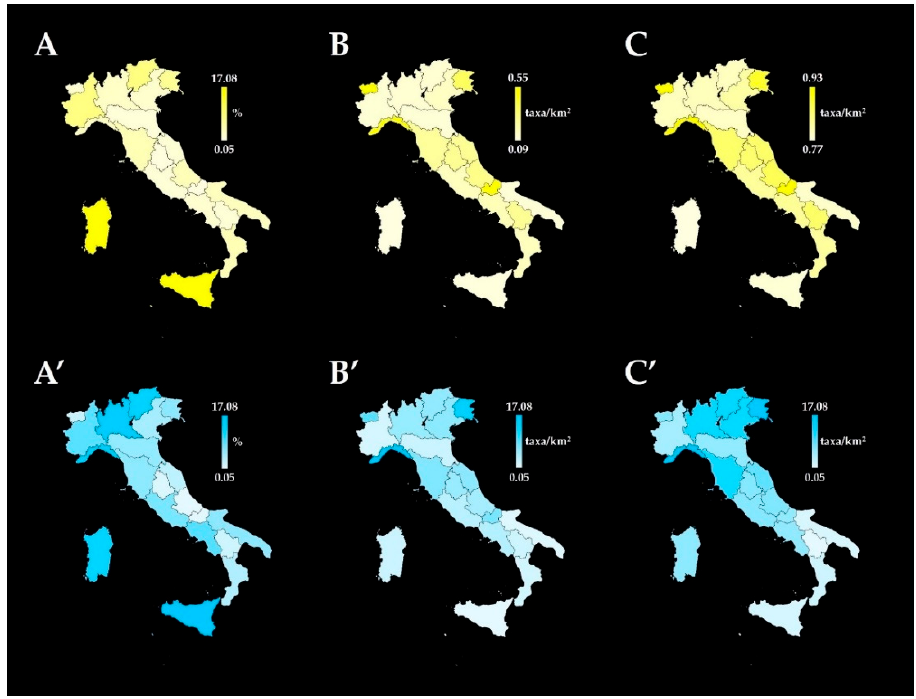
Figure 3. Current percentage of exclusive native (R en ) ( A ) and alien (R ea ) ( A’ ) taxa of the Italian regions. Density of total native (D tn ) ( B ) and alien (D ta ) ( B’ ), and normalized density of total native (DN tn ) ( C ) and total alien (DN ta ) ( C’ ). Values of R en , R ea , D tn , D ta , DN tn and DN ta for each region are available in Table S3. Taxa reported by mistake and as doubts, data deficient, extinct and no longer recorded after 1950 are not